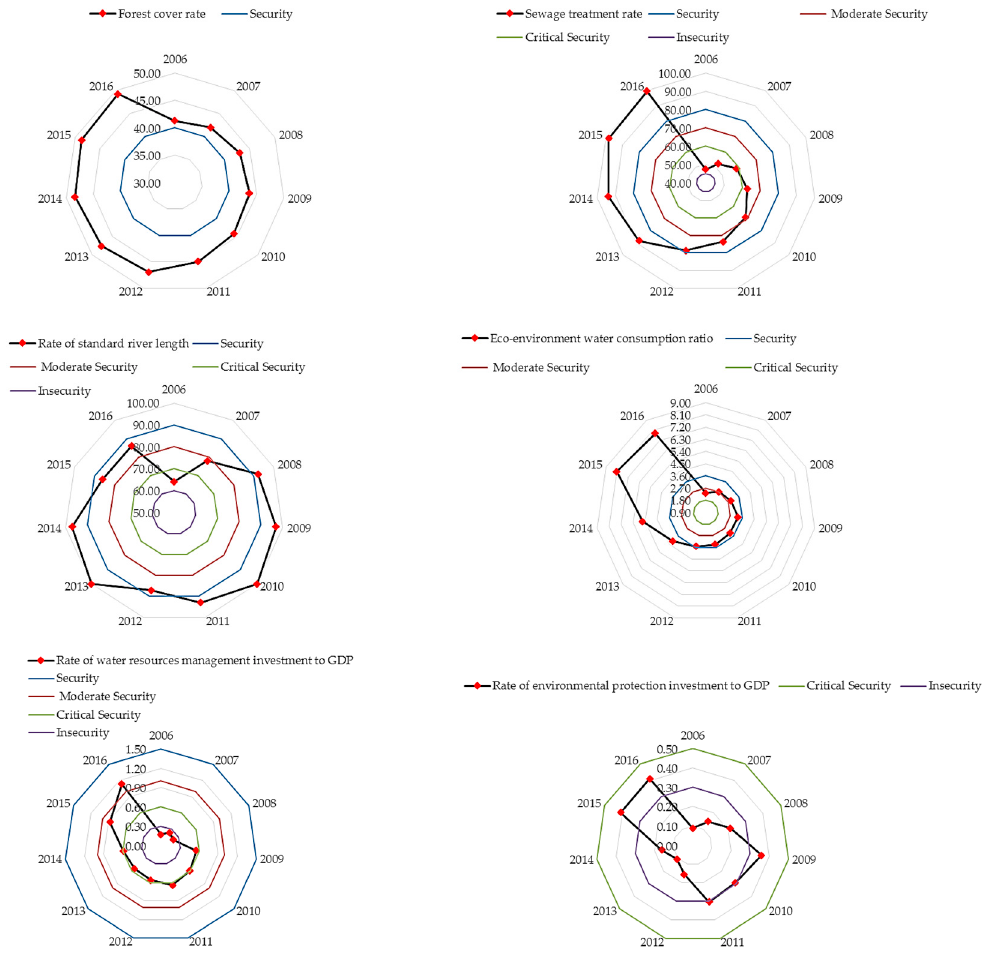
Figure 10. Change of indexes in response subsystem from 2006 to 2016.